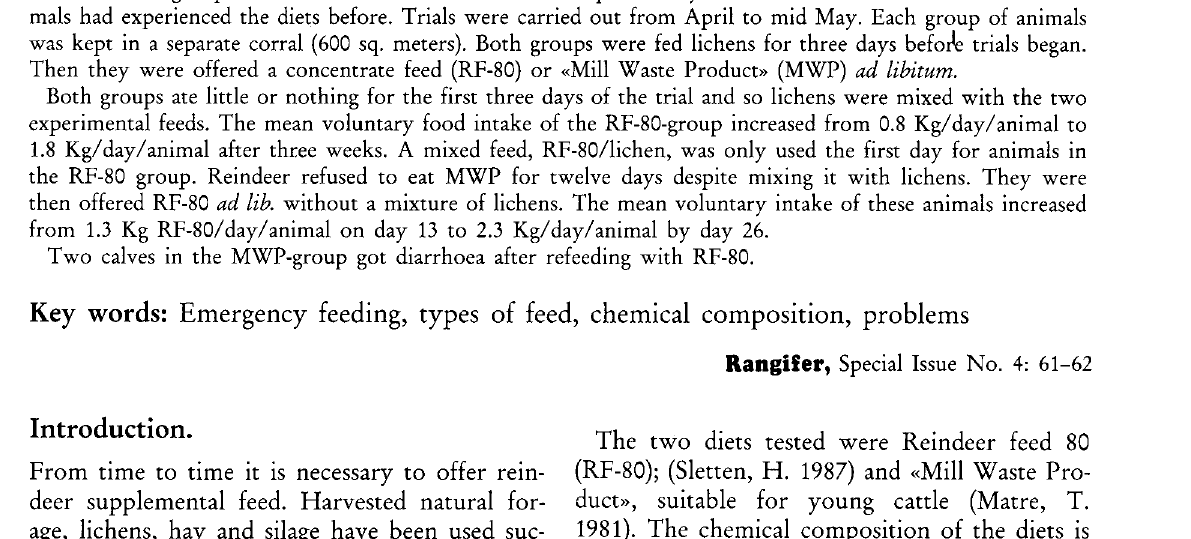
Table 1. The chemical composition of «Mill